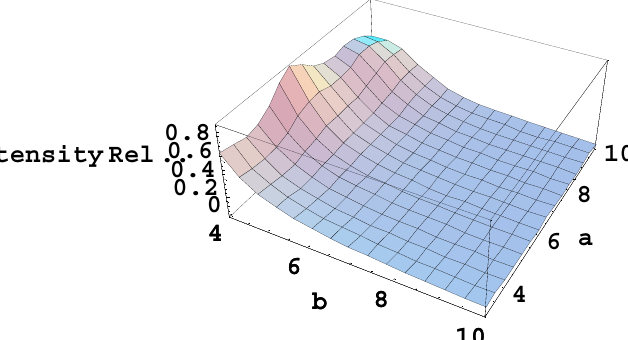
Figure 2. Spatially integrated intensity of the most prominent satellite versus the scaled amplitude a = 3 ħ X k E 0 /(2Z r m e e ω ) of the solitons electric field and versus the scaled distance b = L/ λ of Langmuir solitons in the sequence.